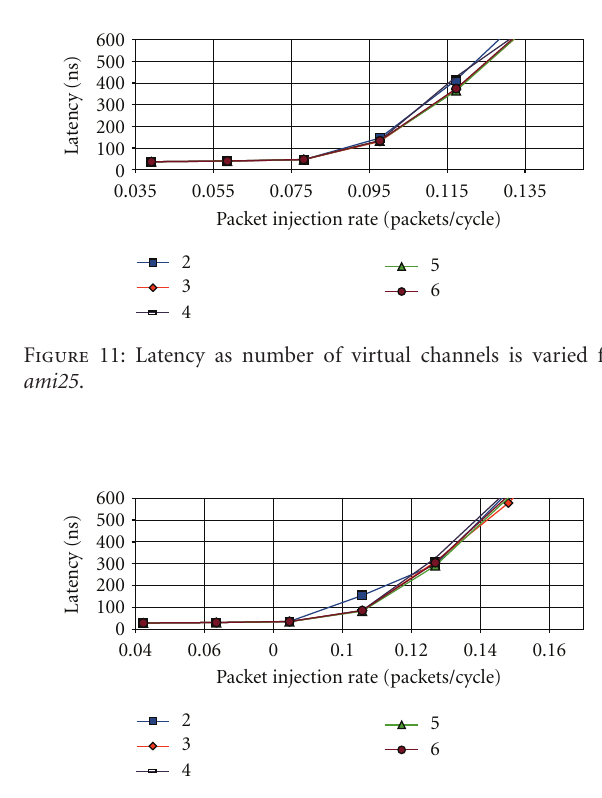
Figure 12: Latency as number of virtual channels is varied for ami33 .